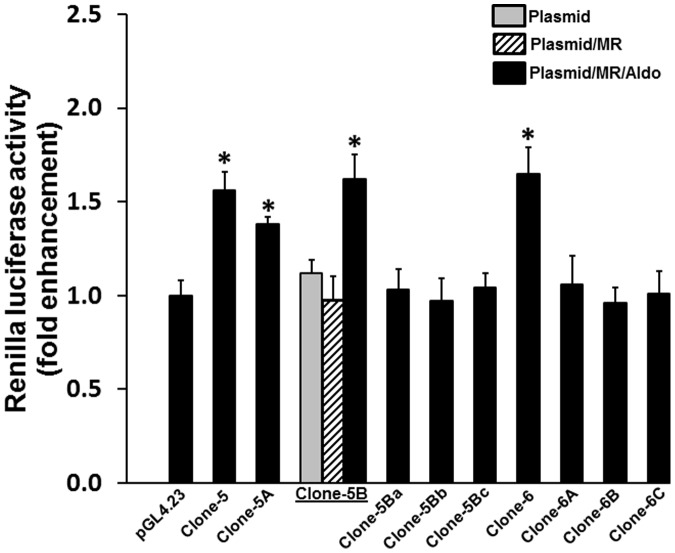
Sub-localization of mineralocorticoid response elements (MRE) in clone-5 and clone-6.The clone-5 was sub-cloned into thirds, clone-5A, clone-5B and clone-5C representing the left, middle and right thirds of clone-5, respectively. Clone-5A, -5B and -5C were tested for MRE/aldosterone responsiveness in the HEK293T cells. The HEK293T cells transfected with clone-5A and clone-5B exhibited a significantly higher luciferase activity compared to the pGL4.23 vector transfected cells. Neither clone-5A nor clone-5B contained candidate MREs as analyzed using the Transcription Element Search System (TESS) or MatInspector. Further sub-clones of clone-5B were made (clone-5Ba and clone-5Bb that represent the left and right half of clone-5B, respectively). (See Figure S1 for the sequences). Luciferase activity was not significantly altered in the HEK239T cells transfected with clone-5Ba and clone-5Bb, compared to the cells transfected with a vector (pGL4.23). Clone-6 was also sub-cloned into thirds (clone-6A, clone-6B, and clone-6C). Similar to the clone-5Ba and clone-5Bb transfected cells, luciferase activity was also not significantly altered in the HECK293T cells transfected with clone-6A, clone-6B and clone-6C compared that of cells transfected with a vector (pGL4.23). Data presented represent mean ± SE of triplicate assays of 3 different experiments. *p<0.05– compared to pGL4.23.